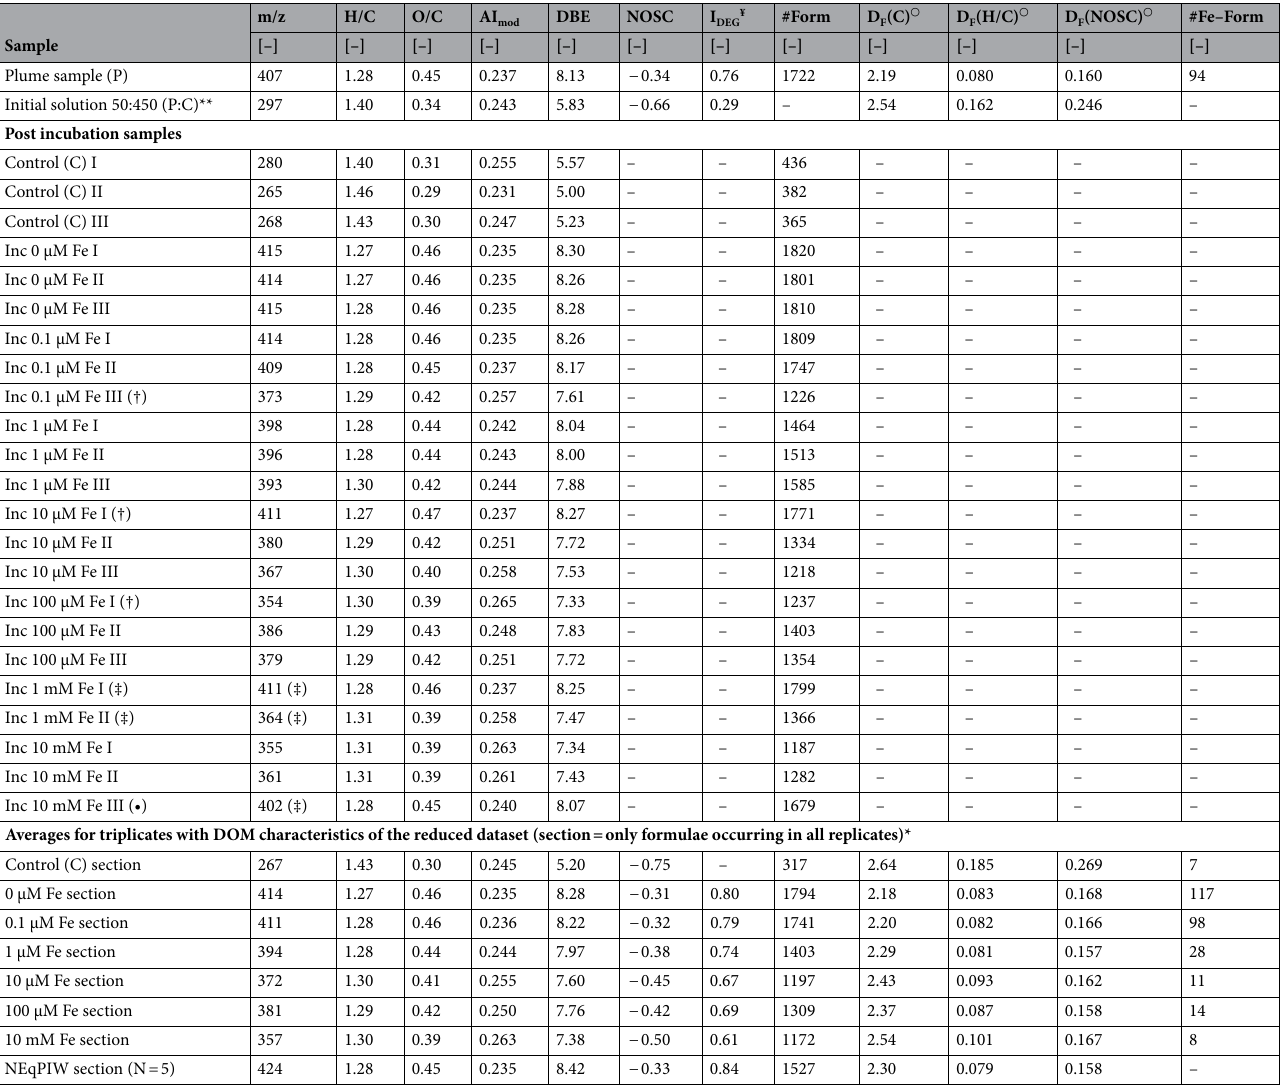
Table 2. Average characteristics of solid-phase extracted dissolved organic matter (SPE-DOM) within the original plume sample and post incubation. Values for the 50:450 (P:C) initial solution were calculated